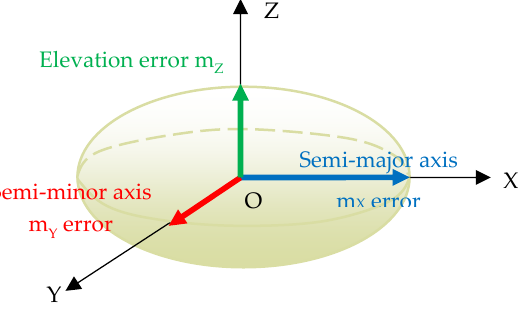
Figure 24. The error ellipse elements.